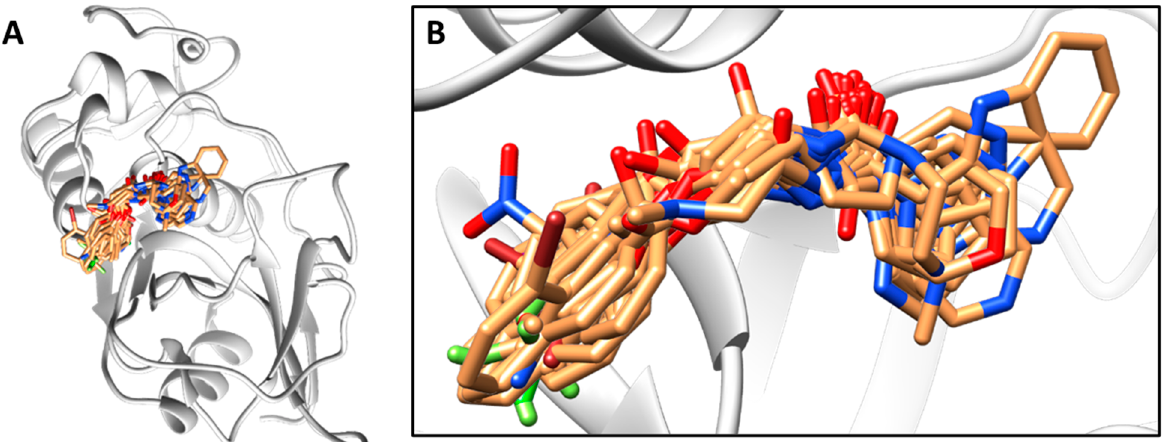
Figure 2. Cruzain inhibitors aligned within the binding site of the X-ray structure of cruzain (PDB 3KKU, resolution of 1.28 Å). ( A ) View of the entire 3D structure of cruzain with the aligned compounds. ( B ) Magnification of the active site of the enzyme and aligned compounds. The structure of cruzain is depicted as a cartoon, and the inhibitors are represented as sticks.